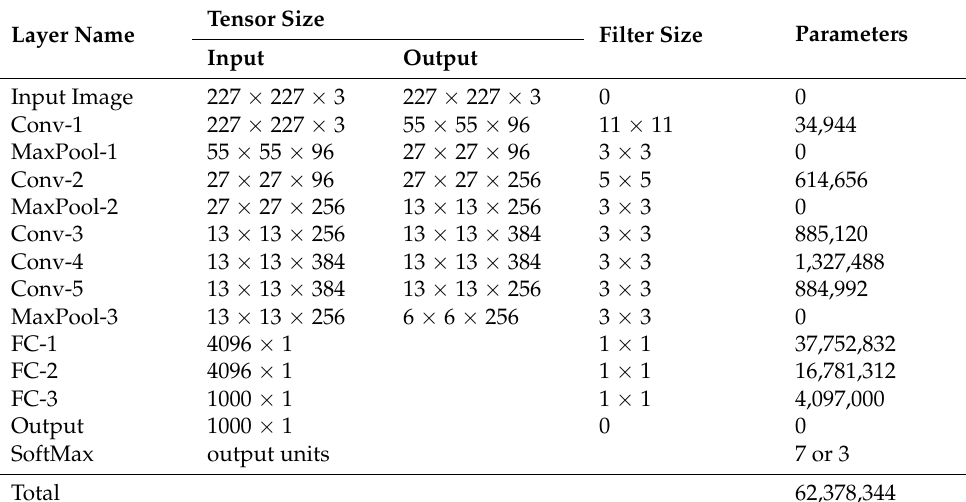
Figure 10. The structure of the AlexNet model used in this study. Table 2. Detailed structure of the AlexNet convolutional neural network.